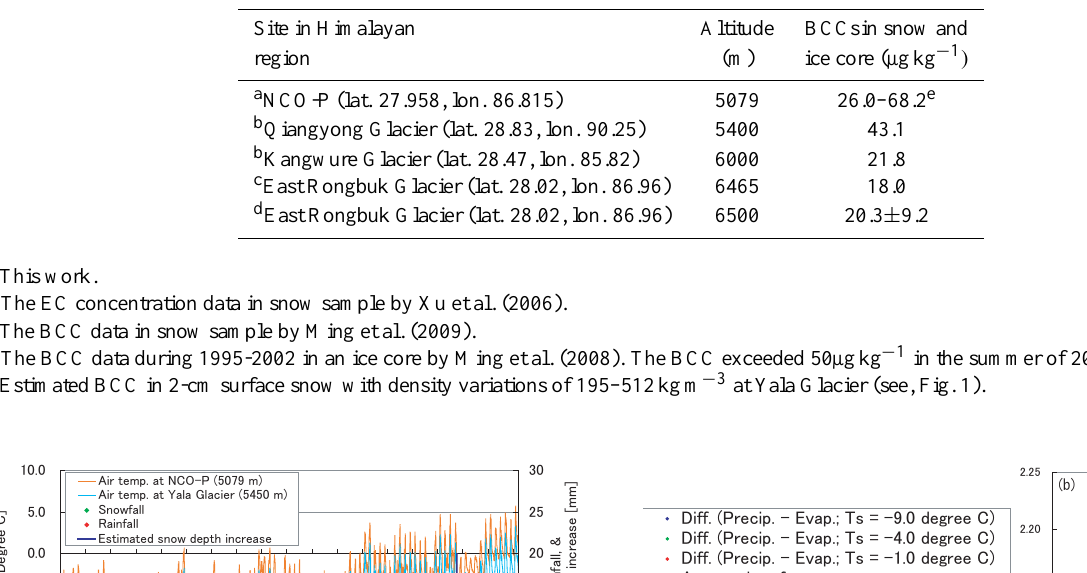
Table 2. Comparison between estimated (a) and observed (b, c, d, e, f) BCCs in surface snow and ice core for locations reported in Fig. 1.